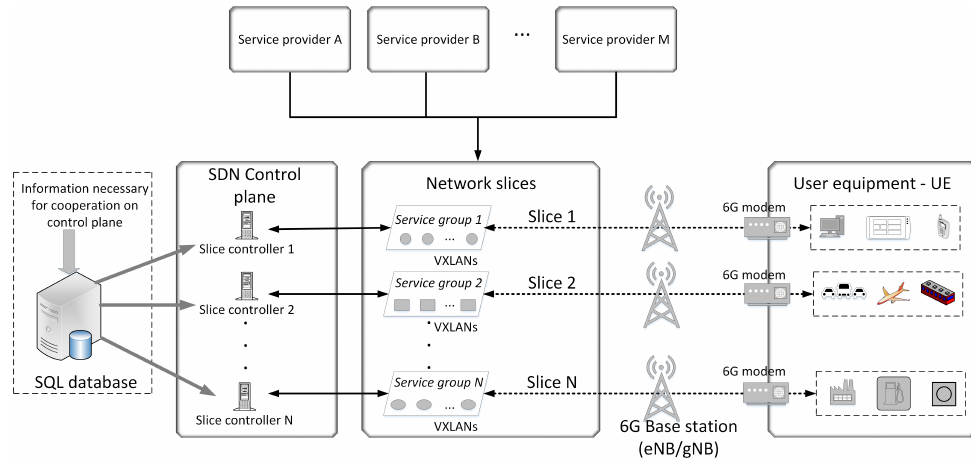
Figure 1. The proposed model of 5G/6G multi-slice